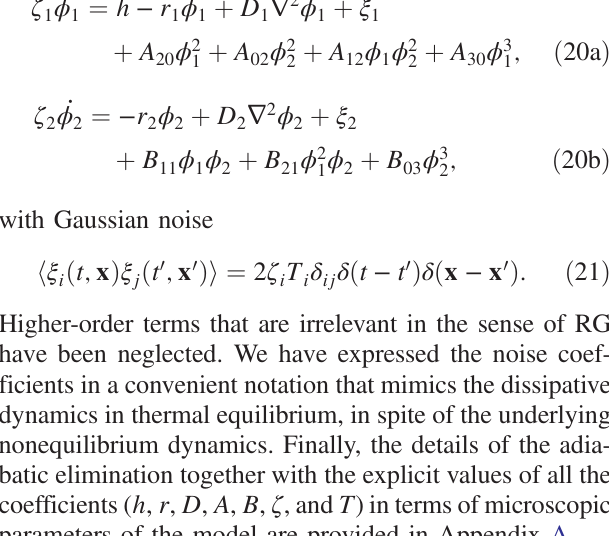
FIG. 6. Dynamics of gapped (fast or massive) and soft (slow or massless) modes with arrows indicating the linear (in ϕ the two modes. Near the critical point, the gapped mode quickly decays to a straight line defined by the slow direction of the soft mode. (a) Relaxation of the field ψ with the soft and gapped modes lying along the angles π = 3 and 0, respectively. (b) Relaxation of the field ψ B 1 = 3 with the soft and gapped modes lying along the angles − π = 6 and π = 6 , respectively. (c) Relaxation of the field ψ for Δ c ¼ Δ 2 = 3 with the soft and gapped modes lying along the angles 0 and π = 3 , respectively. (We have adopted units where Δ þ J ¼ 1 c ¼